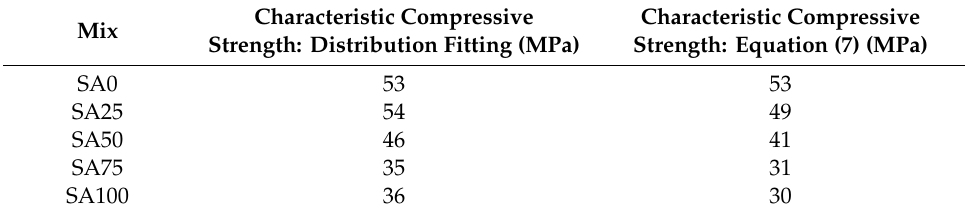
Table 17. Comparison between the characteristic strength obtained by calculation and that obtained through the